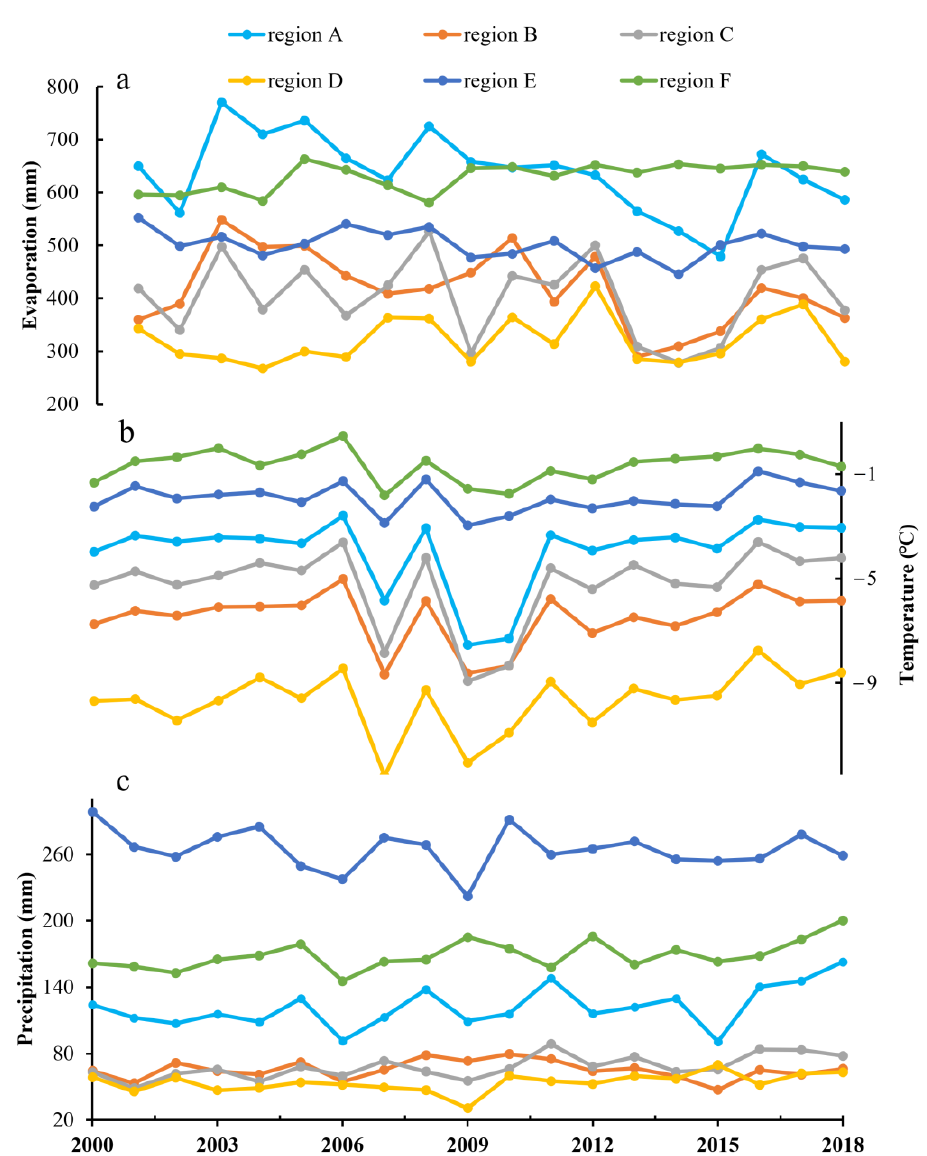
Figure 8. Climate change trends of various elements in different areas of the TP. ( a ) Evaporation; ( b ) Temperature; ( c ) Precipitation.